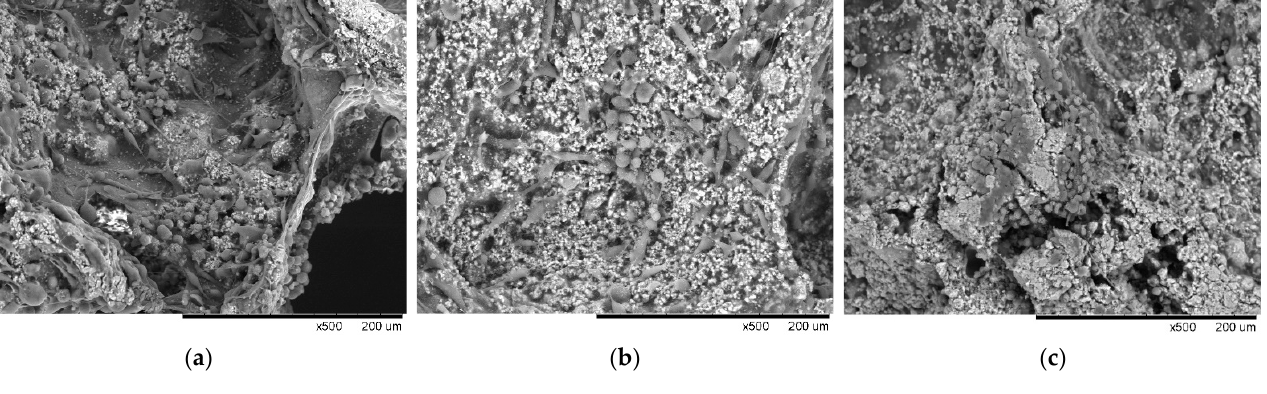
Figure 7. MDA-MB-231 metastasis on GHG scaffold: ( a ) MDA-MB-231 was dynamically cultured in GHG scaffold until the seventh day, and it was observed that the cells proliferated/metastasized slowly toward two-dimensional planes on the scaffold; ( b ) the EGF was immobilized on the scaffold where cells proliferated/metastasized in the direction of the hole in a three-dimensional manner; ( c ) MCF-7 was dynamically cultured under the conditions of ( a ) until the seventh day, at which point a similar phenomenon to that described in ( b ) could also be observed. (Scale bar: 200 µm) (The “×” in scale bar in the figure represents magnification).